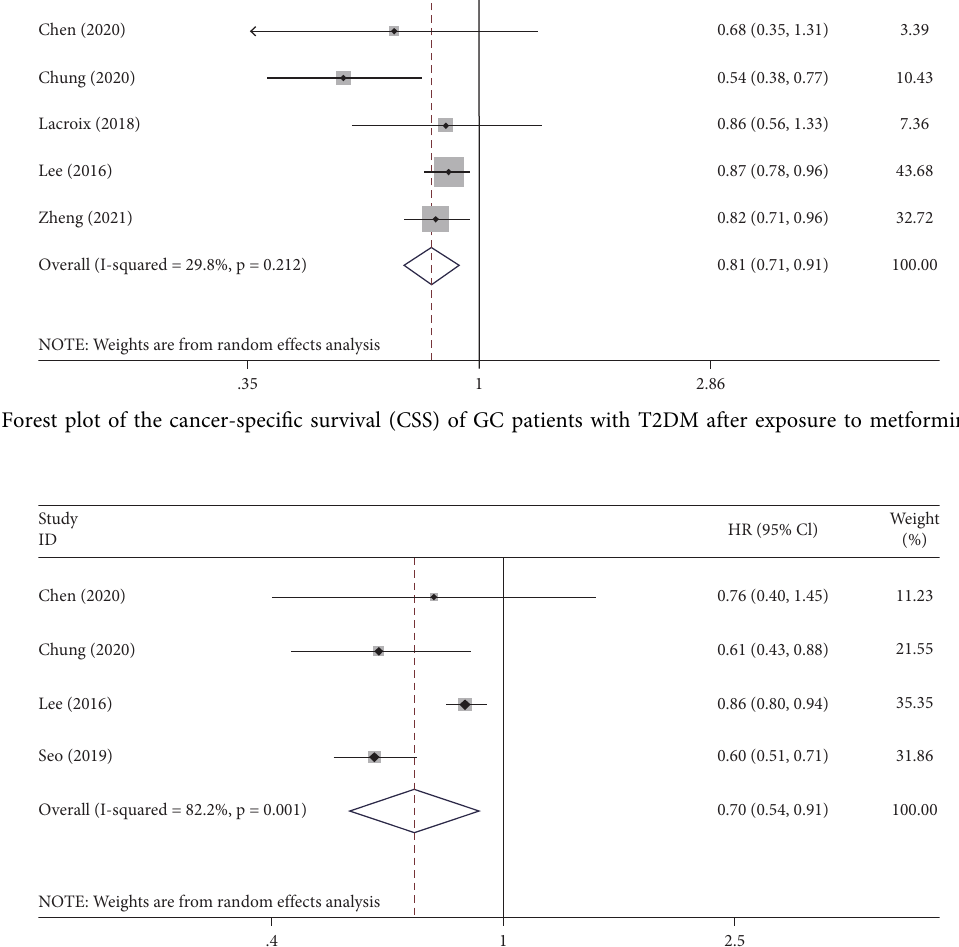
Figure 4: Forest plot of the progression-free survival (PFS) of GC patients with T2DM after exposure to metformin ( p �